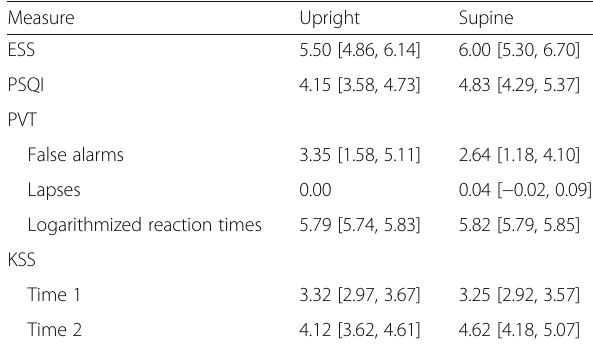
Table 3 Means and 95% Bayesian credibility intervals (in brackets) of measures obtained with the Epworth Sleepiness Scale, the psychomotor vigilance task, and the Karolinska Sleepiness Scale for the two posture groups in Study